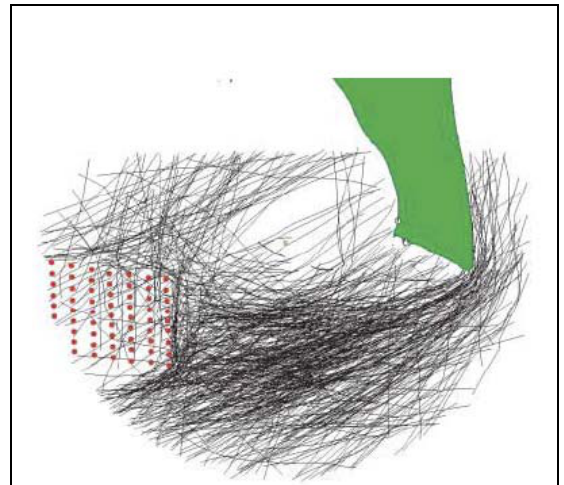
Figure 3. Radar registration from the Nysted offshore wind farm applied on a GIS-platform. Red dots indicate individual wind turbines, green area the land, green dot the sitting of the radar and black lines migrating waterbird flocks determined visually at the Nysted offshore wind farm. Adapted from Kahlert et al.